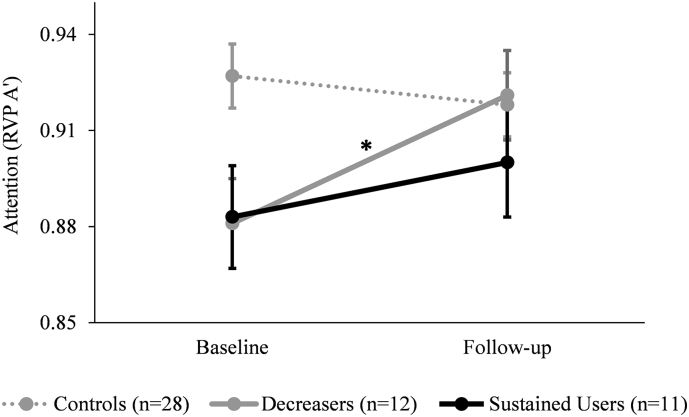
Changes in attention performance.Change in sustained attention performance from baseline to follow-up. The analysis was corrected for verbal IQ, ADHD-SR score, the amount of alcohol consumed between baseline and follow-up, and the time interval between the two measurements. The follow-up values were additionally adjusted for test-retest effects. Decreasers P = .00003 Sustained Users P = .11;Sidak post-hoc tests: *P < .05.